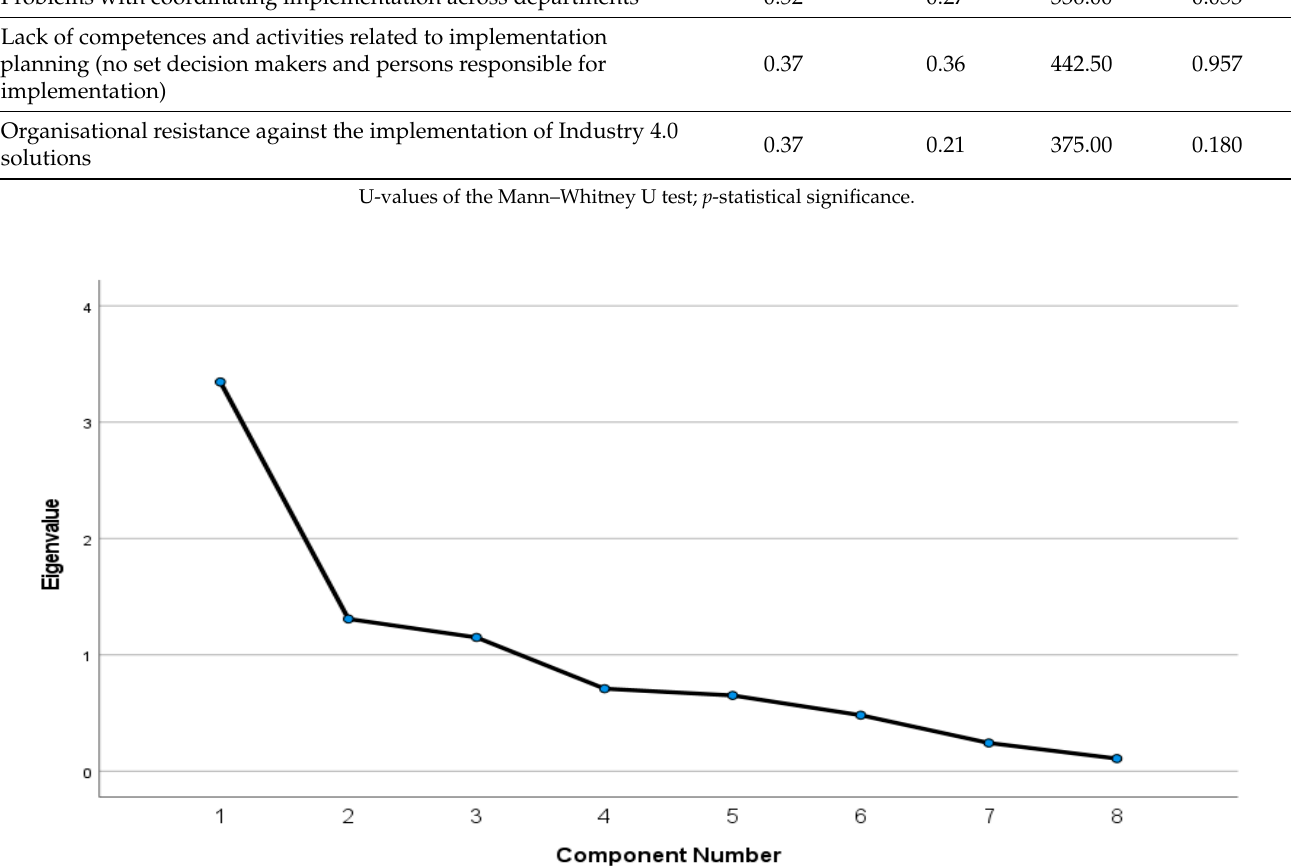
Figure 3. Scree plot in the principal component analysis regarding barriers to implementing Industry 4.0 solutions. Based on the Kaiser criterion, three components were extracted. Table 7 presents factor loadings in a pattern matrix. The values lower than 0.4 were suppressed for